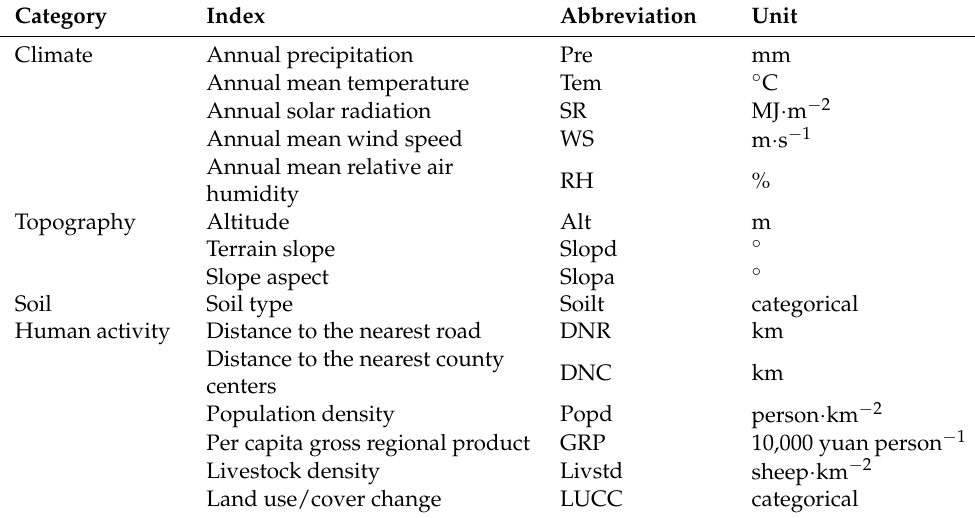
Table 1. Potential driving factors of vegetation variation in the study area.